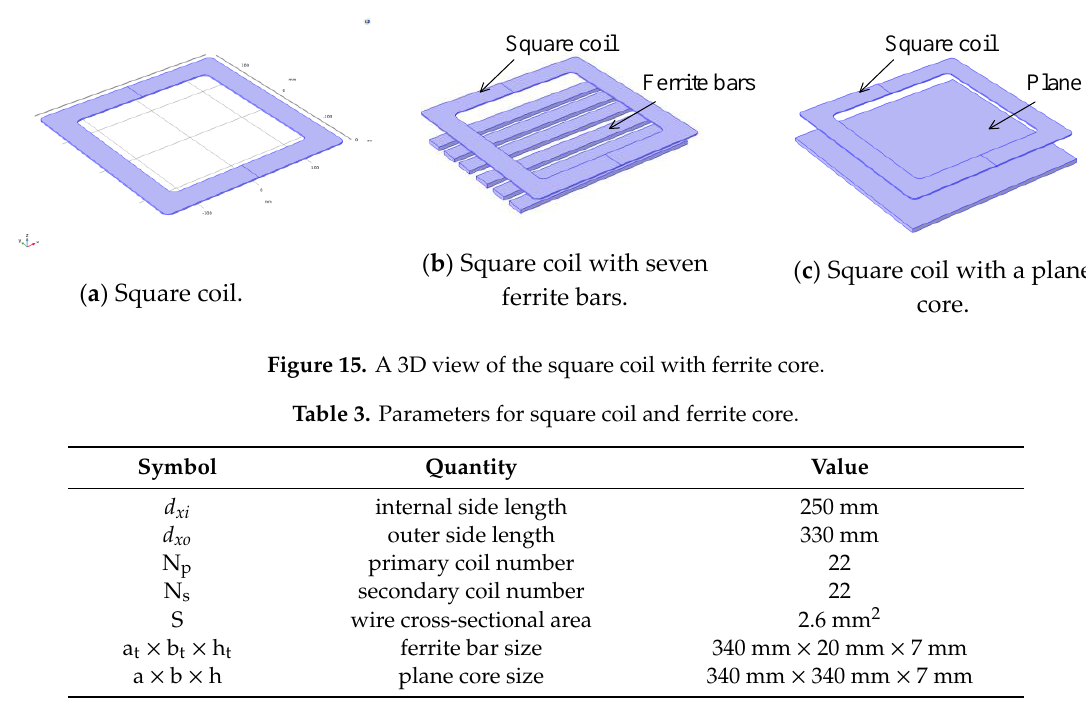
Table 3. Parameters for square coil and ferrite core. Figure 14. Coupling coe ffi cient versus the outer side length. Figure 14. Coupling coefficient versus the outer side length.